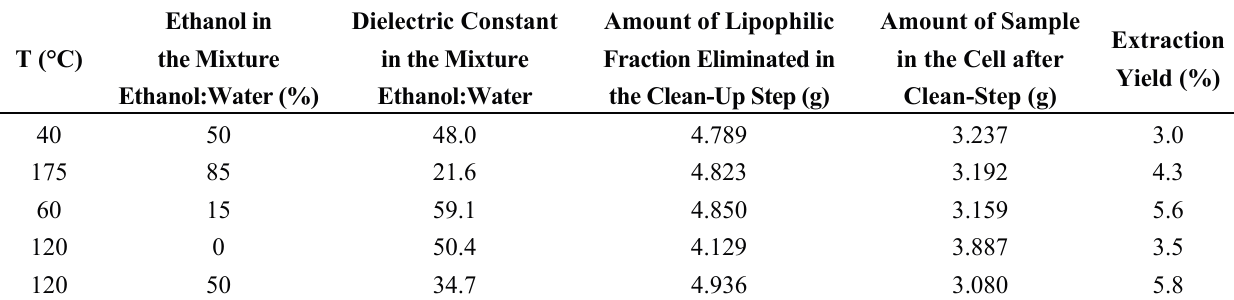
Table 1. Extraction conditions, dielectric constant and extraction yield obtained from the pressurized liquid extraction (PLE) extraction of filter cake (to carry out the PLE, 8 g of filter cake were loaded in the extraction